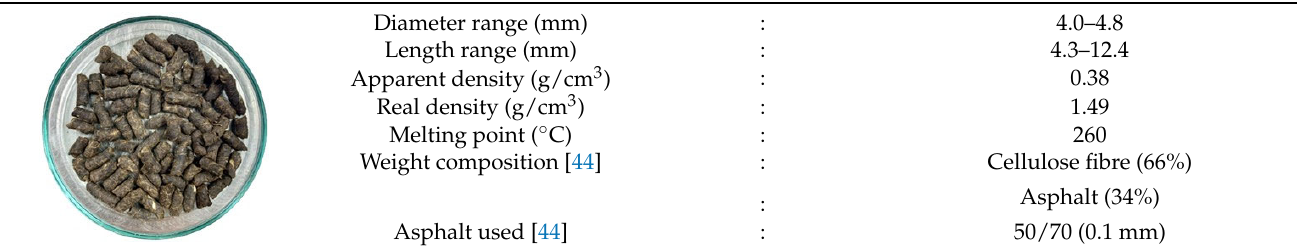
Figure 2. SEM images of the WTTF ‐ based additive used in this study: ( a ) 500 μ m; ( b ) 100 μ m.